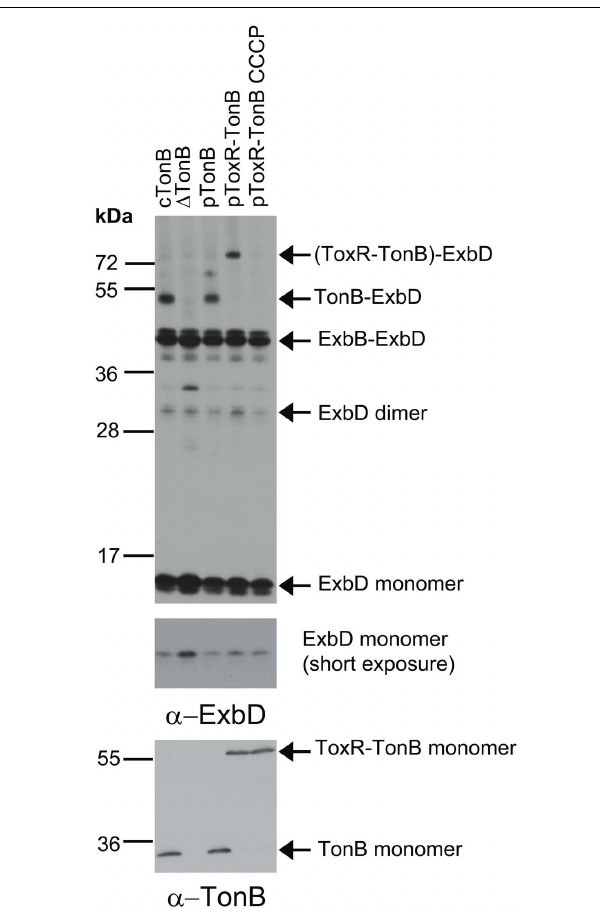
FIGURE 3 |ToxR–TonB makes the pmf-dependent crosslink with ExbD. Crosslinking was performed as described in Section “Materials and Methods” with the following strains: cTonB (W3110 expressing chromosomally encodedTonB and ExbD); Δ TonB (KP1344); pTonB (KP1344/pKP325); pToxR–TonB (KP1344/pKP1529); and pToxR–TonB CCCP (KP1344/pKP1529 treated with 50 μ M CCCP). L-Arabinose was added to induce expression of plasmid-encodedTonB as follows: 0.00075% for pTonB and 0.00046% for pToxR–TonB. Complexes were detected on immunoblots of 13% SDS-polyacrylamide gels using ExbD polyclonal antibodies (upper two panels). Uncrosslinked monomericTonB and ToxR-TonB levels were visualized with the monoclonal anti-TonB antibody 4F1 (bottom panel).The molecular mass standards (kDa) are shown on the left.